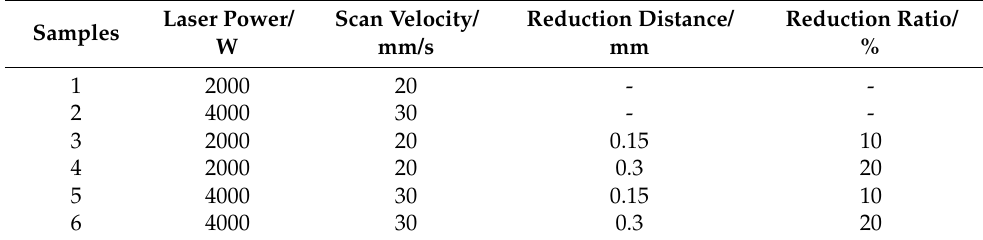
Figure 1. Schematic of laser surface melting consecutive point-mode forging process. Table 1. Parameters of the LSM-CPF treatment samples.